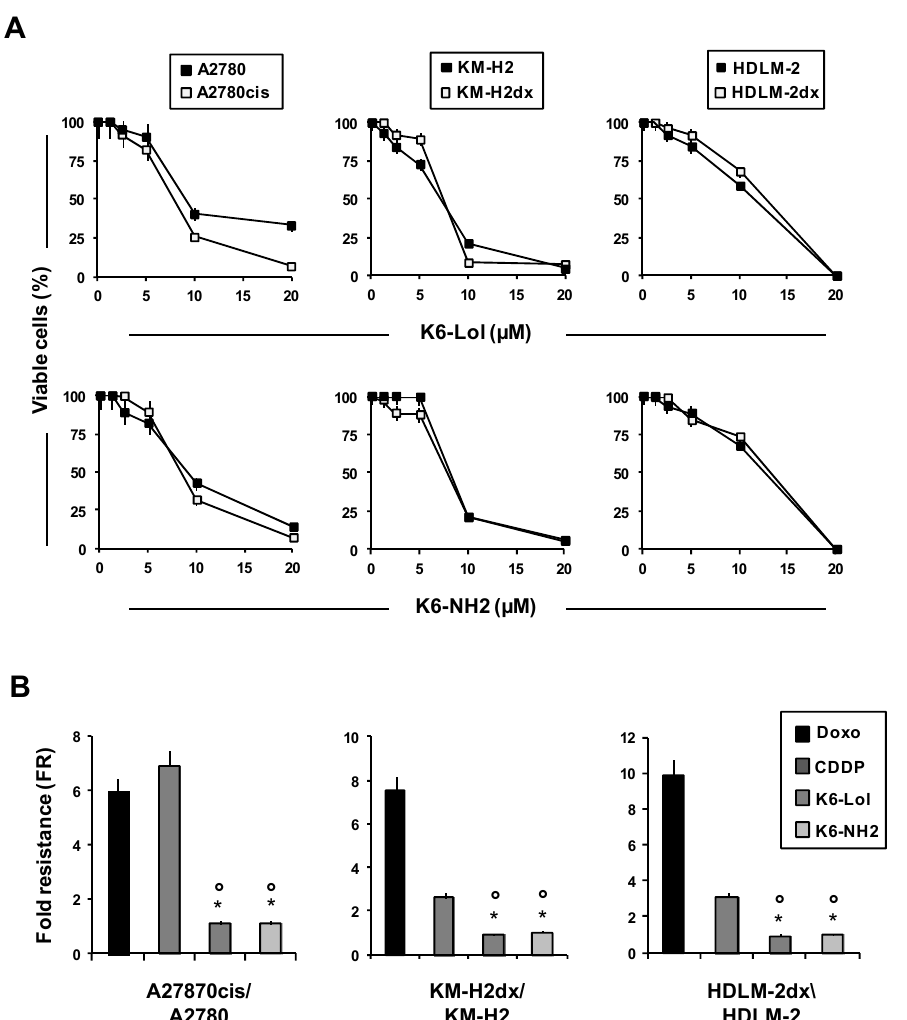
Figure 2. K6-Lol and K6-NH2 kill HRS and OvCa cells, and are equally active in doxorubicin and cisplatin resistant cells. Cytotoxicity assay. Tumor cells were exposed to increasing concentrations of peptaibols. ( A ) After 24 h cell viability was evaluated with MTT assay in A2780 and A2780cis, and MTS assay in KM-H2, KM-H2dx, HDLM-2 and HDLM-2dx. Results are mean and SD of three independent experiments. ( B ) Fold resistance, calculated as the ratio of the IC 50 of drug-resistant cells to that of their corresponding parental cell lines. * p < 0.05 vs. doxorubicin and ◦ p < 0.05 vs. cisplatin. Student’s t test. Doxo, doxorubicin; CDDP, cisplatin. For each cell line, we calculated the IC 50 , i.e., the concentration of drug to decrease cell viability to 50%. The ratio of the IC 50 of the drug-resistant cell line to that of its parental cell line is the fold resistance (FR). The higher the FR value, the higher the drug-resistance. HDLM-2dx and KM-H2dx were both about nine times less sensitive to doxorubicin than their parental cell lines (FR = 9), and 3.11 and 2.6 to cisplatin (FR = 3.11 and FR = 2.6, respectively), but had comparable sensitivity to K6-Lol and K6-NH2 with FR values near to 1 (Figure 2B). In addition, our results suggest that peptaibols may be active in HRS cells with intrinsic resistance to BV (HDLM-2 cells) [31,32], or likely with acquired resistance to BV, characterized by the up-regulation of MDR1 (L-428R and KM-H2R) [26]. A2780cis were more resistant to both cisplatin (FR = 8) and doxorubicin (FR = 5.6) than parental A2780 cells but had similar sensitivity to both peptaibols (FR value near 1.0) (Figure 2B). These results demonstrated that the substitution of Lol with Leu-NH2 (leading to the less expensive analog K6-NH2) did not significantly modify the